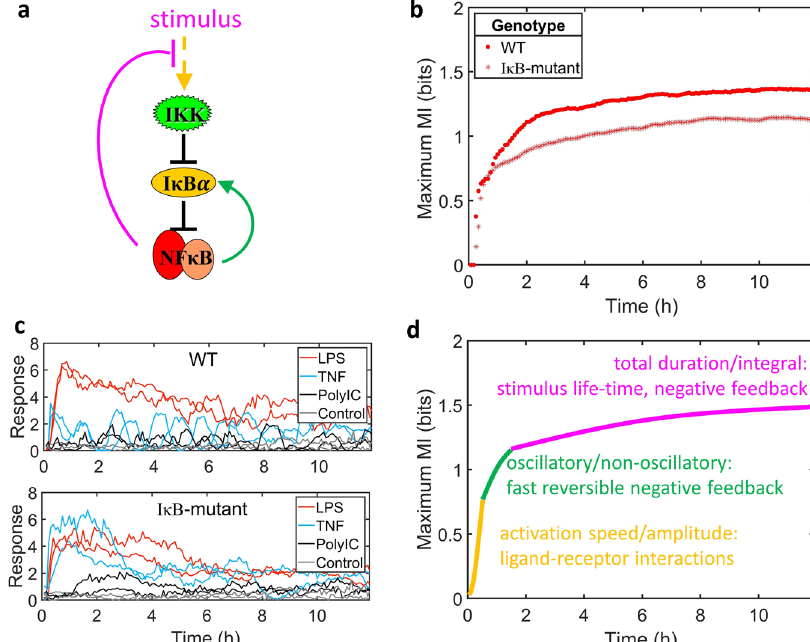
Fig. 5 Phases of information accumulation may be mapped to regulatory motifs. a Schematic of NF κ B signaling with molecular mechanisms operating at different timescales shown in different colors. The I κ B-mutant has a reduced induction of I κ B α by NF κ B (green arrow). To investigate the role of the feedback, we considered three stimuli (10 ng/ml TNF, 100 ng/ml LPS, 50 μ g/ml Poly(I:C)) that lead to distinct signaling dynamical patterns between the genotypes. b The maximum dMI for NF κ B responses to three stimuli (10 ng/ml TNF, 100 ng/ml LPS, 50 μ g/ml Poly(I:C)) in wild-type and mutant cells lacking the I κ B α feedback. The mutant shows a diminished dMI increase between 1 and 2 h. c Representative response trajectories for the two genotypes, illustrating that mutant cells lack oscillatory responses. d Schematic indicating how speci fi c phases of information accumulation may be mapped to different molecular mechanisms that mediate speci fi c dynamical features in the responses. The second phase was diminished in the I κ B-mutant that is defective in producing oscillations; the fi rst and third phases are conjectured to be mediated by activation amplitude and total duration of signaling, respectively. Source data are provided as a Source Data fi